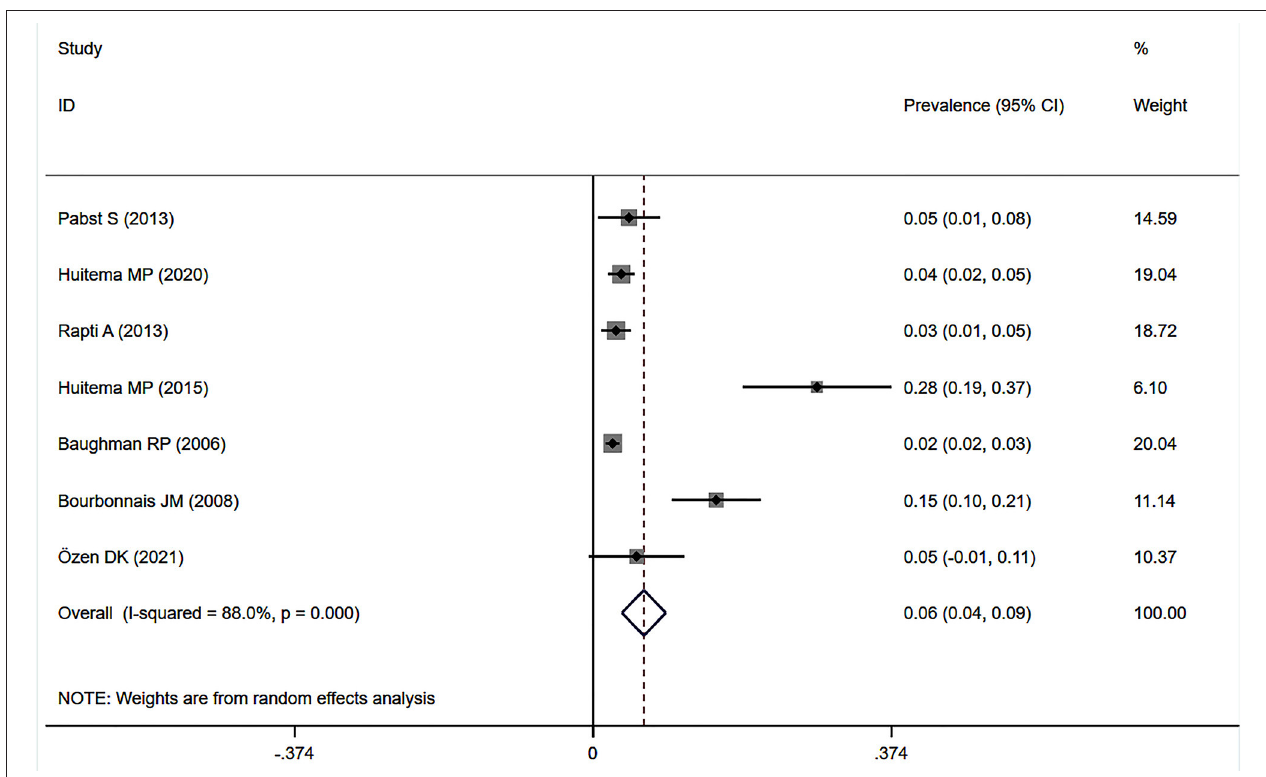
FIGURE 3 | Forest plot of the pooled prevalence of SAPH by RHC in general sarcoidosis population. SAPH, sarcoidosis-associated pulmonary hypertension; RHC, right heart catheterization.